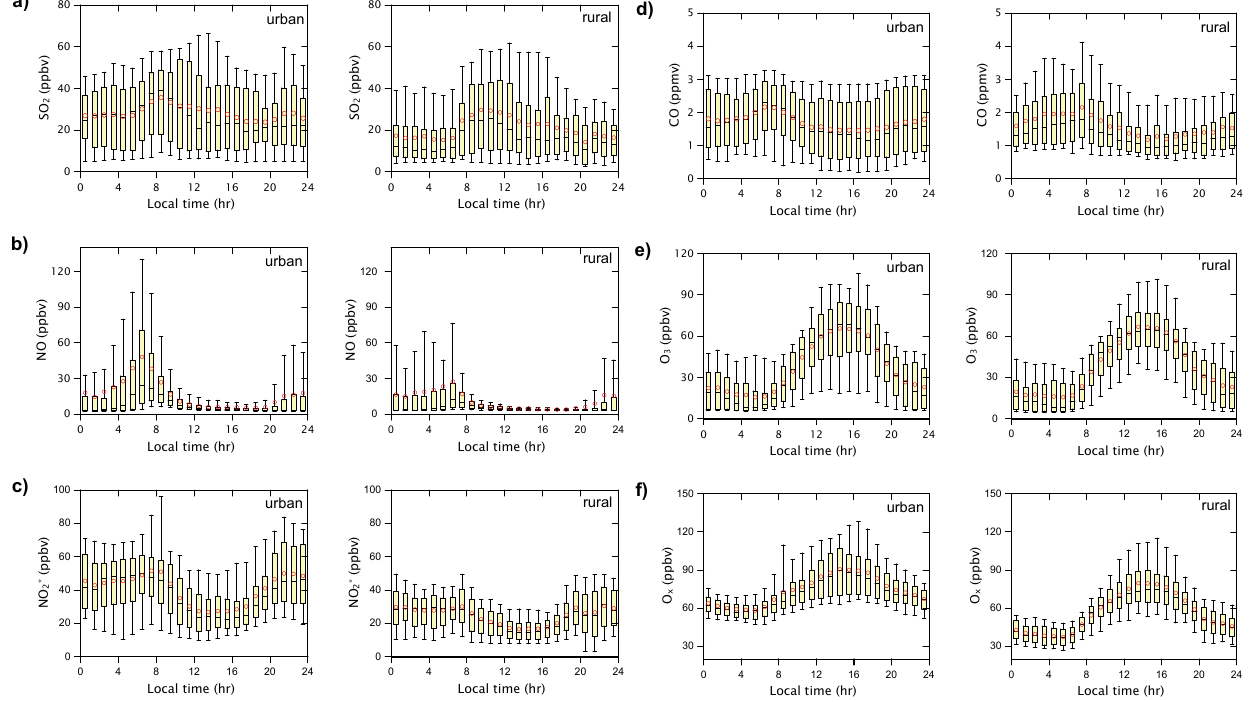
Fig. 7. Diurnal cycles of (a) SO 2 , (b) NO, (c) NO ∗ , (d) CO, (e) O 3 , and (f) O x at the Beigongda (urban) and Xin’an (rural) sites during 2 IPAC-NC. Lower (upper) error bars and yellow boxes are 10th (90th) and 25th (75th) percentiles of the data grouped in one-hour intervals, respectively. Hyphens inside the boxes are the medians and red circles the mean